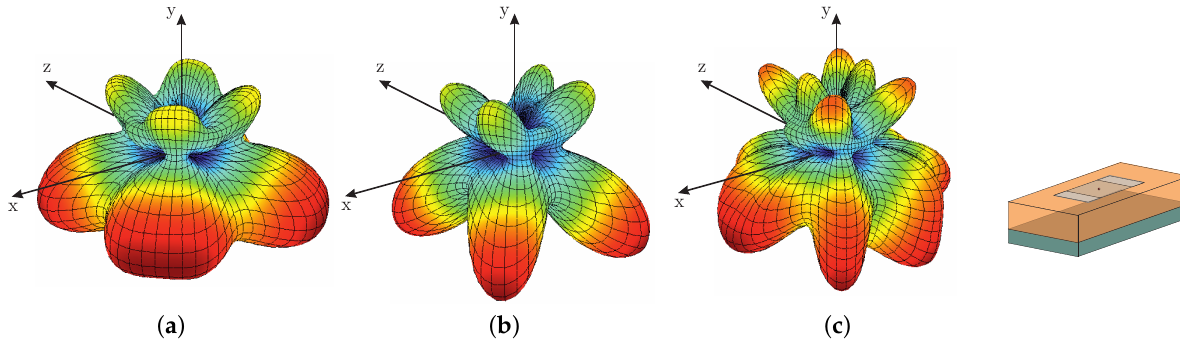
Figure 11. Three-dimensional radiation patterns of the proposed graphene antenna for ( a ) µ c ,out = 0.1eV, ( b ) µ c ,out = 0.5eV, and ( c ) graded increment of matching component’s chemical